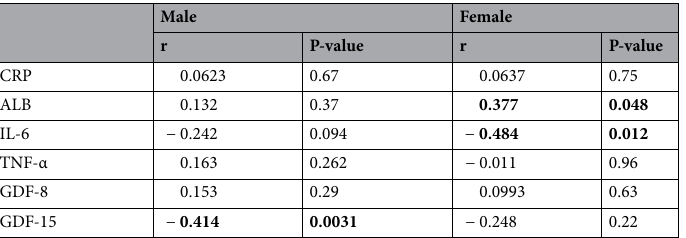
Table 5. Pearson correlation with the SMI of male and females. Data were analyzed by the Pearson product- moment correlation coefficient. CRP C-reactive protein, ALB albumin, IL-6 interleukin-6, TNF-α tumor necrosis factor-alpha, GDF-8 growth differentiation factor-8, GDF-15 growth differentiation factor-15, SMI skeletal muscle mass index. Significant values are in bold.